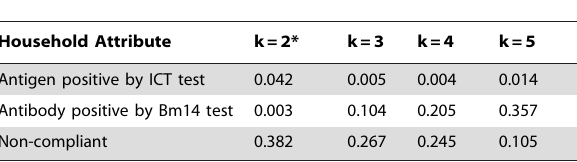
Table 4. Reasons for noncompliance.